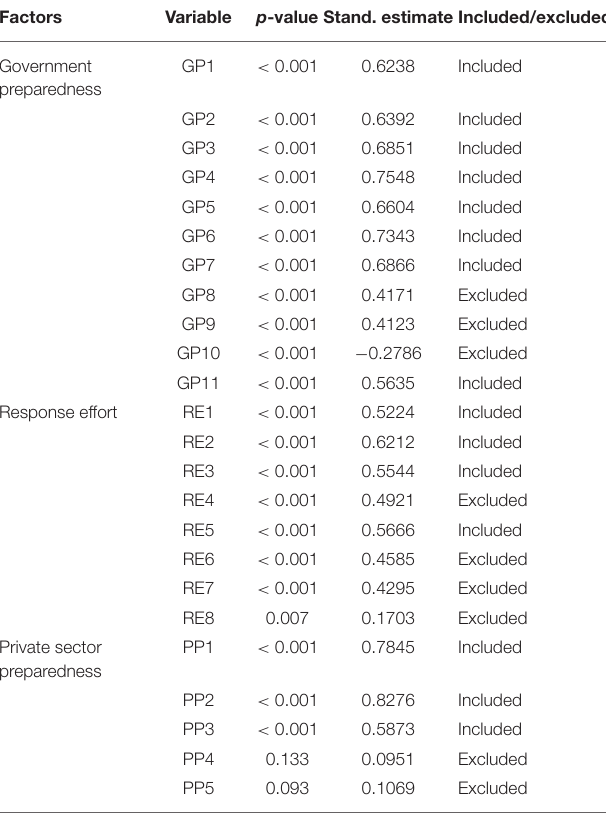
TABLE 4 | Initial factor loadings and P -value of the items. Factors